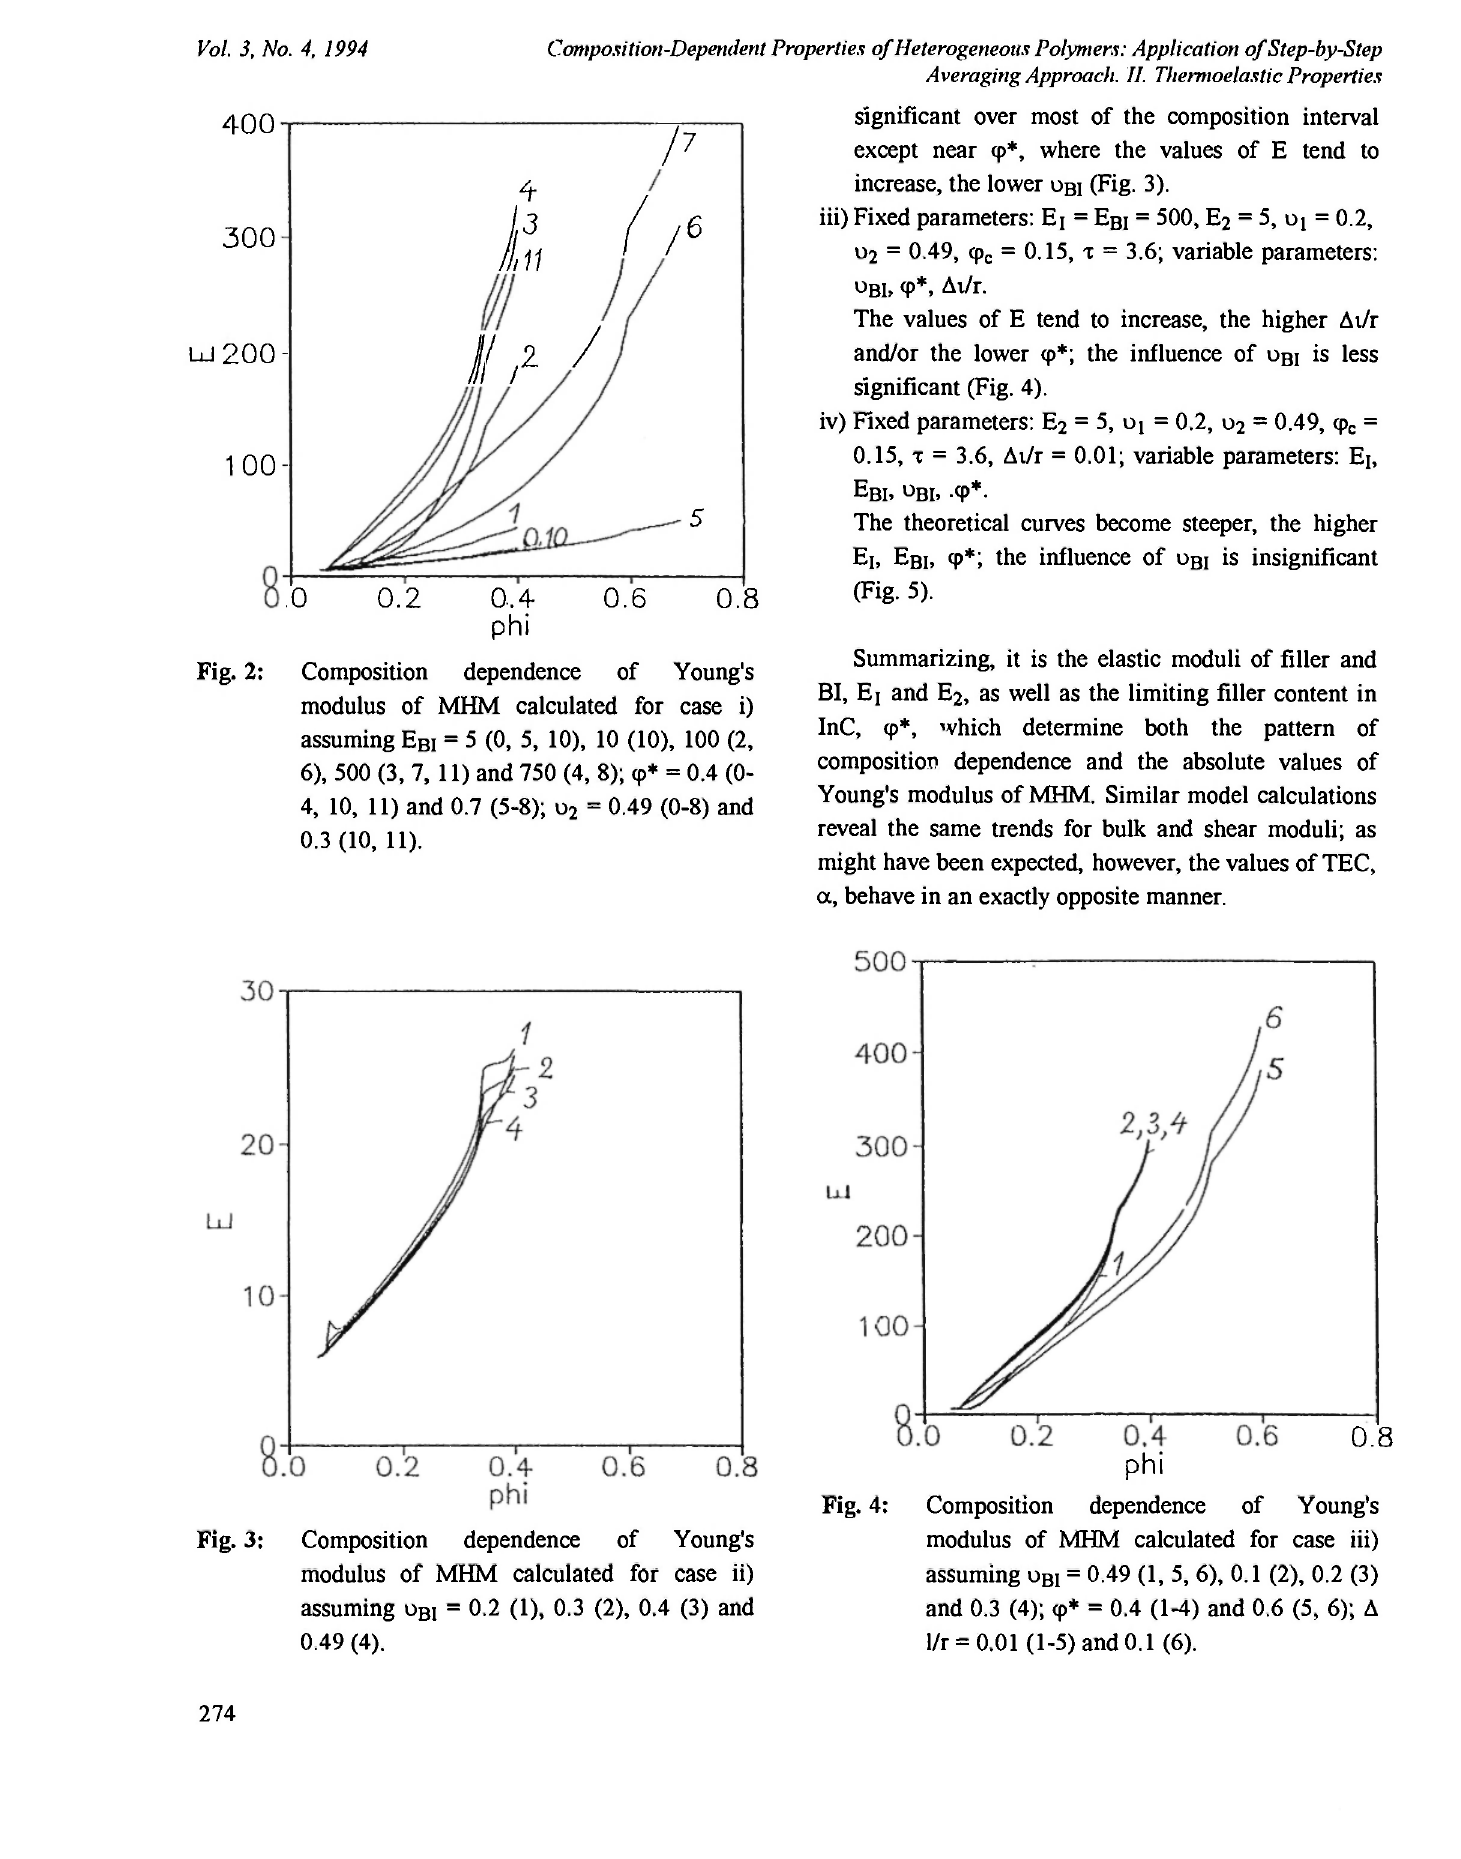
Fig. 3: Composition dependence of Young's modulus of MHM calculated for case ii) assuming υ ΒΙ = 0.2 (1), 0.3 (2), 0.4 (3) and 0.49 (4).